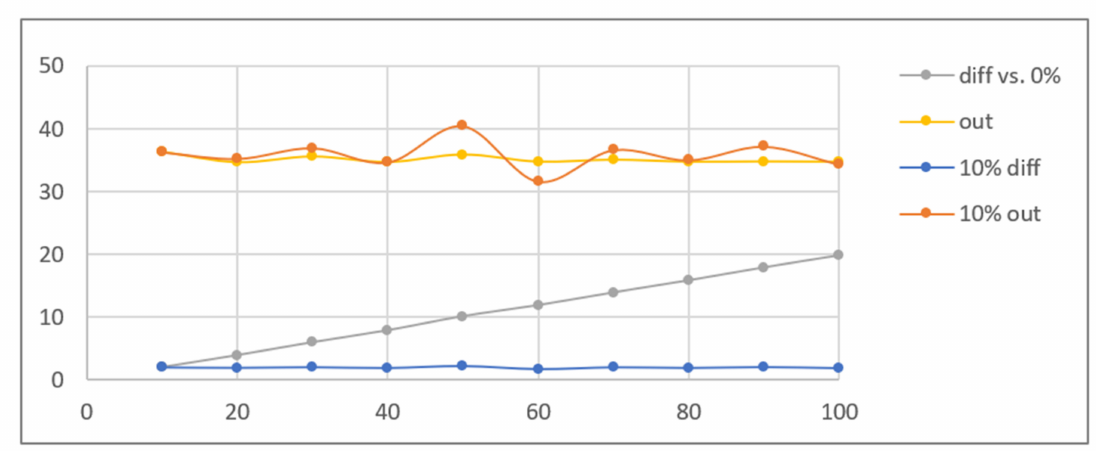
Figure 9. Results of simulation with ID card images for increasing UV light share (10 ÷ 100%) and the ambient light image as a reference (0–10%, 0–20%, 0–30%, etc.), and using pairs of composite images with 10% share difference (0–10%, 10–20%,